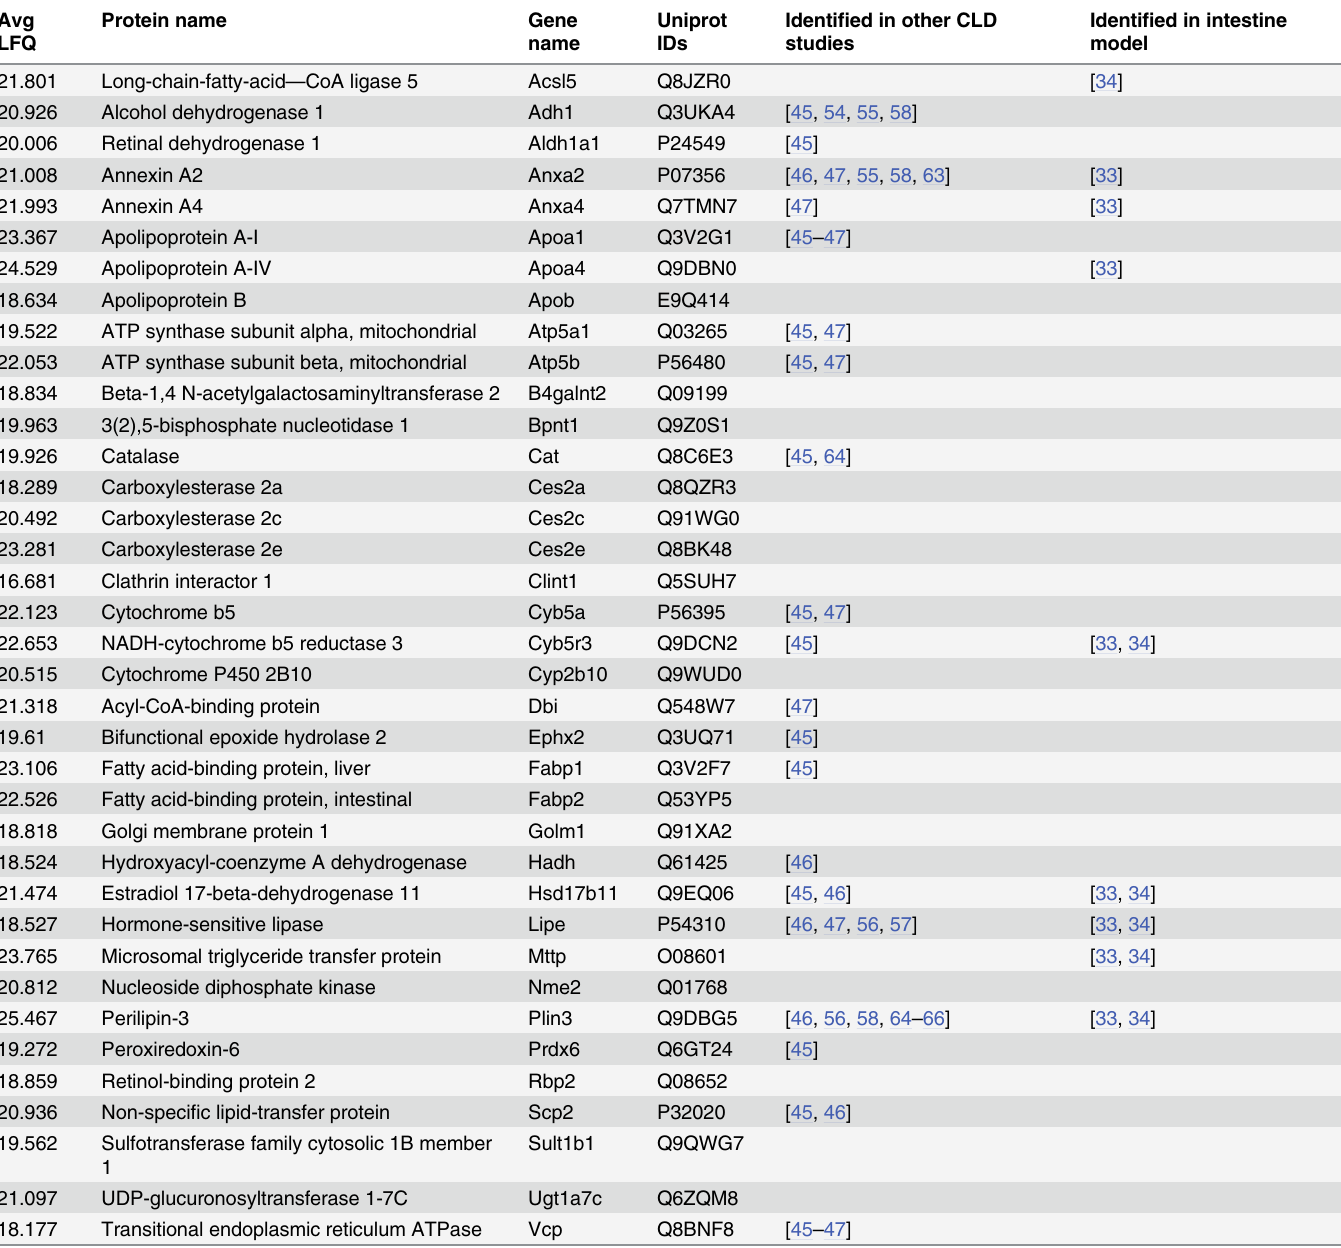
Table 2. A sub group of proteins are associated with known lipid related